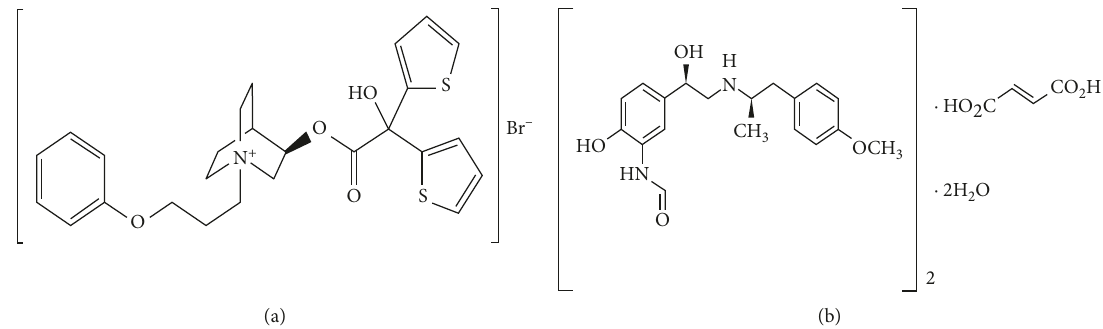
Figure 1: Chemical structure of (a) aclidinium bromide and (b) formoterol fumarate dihydrate.